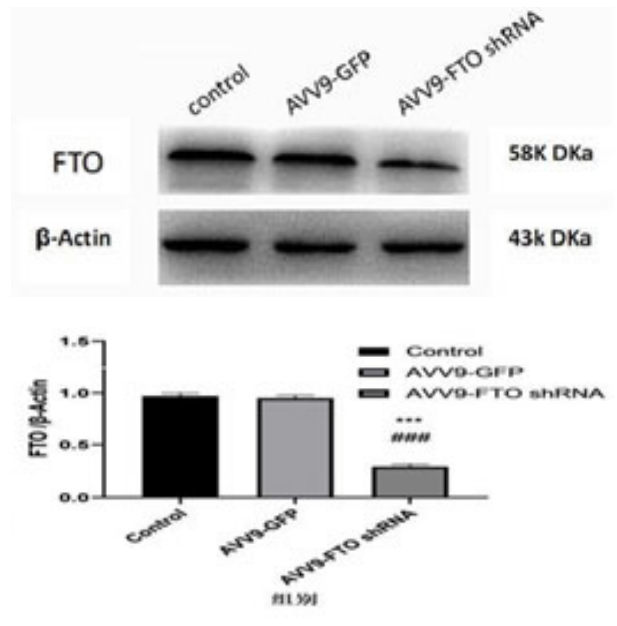
Fig. 2 – Western blot results of fat mass and obesity-associated gene (FTO) protein expression in the vulnerable plaque group, empty load group, and FTO knockdown group. ***P<0.001 vs. control group; ###P<0.001 vs. AVV9-GFP group. AVV9=adeno-associated virus-9; GFP=green fluorescent protein; shRNA=short hairpin ribonucleic